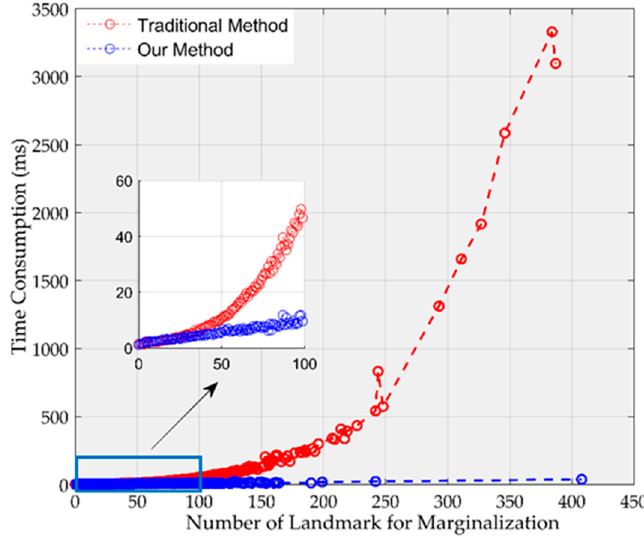
Figure 6. The comparison of the time consumption of our method and the traditional method.